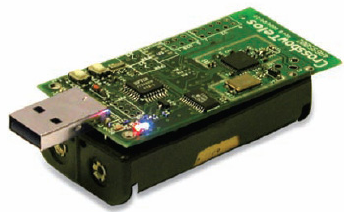
Figure 1. Example of a wireless sensor and actuator node.